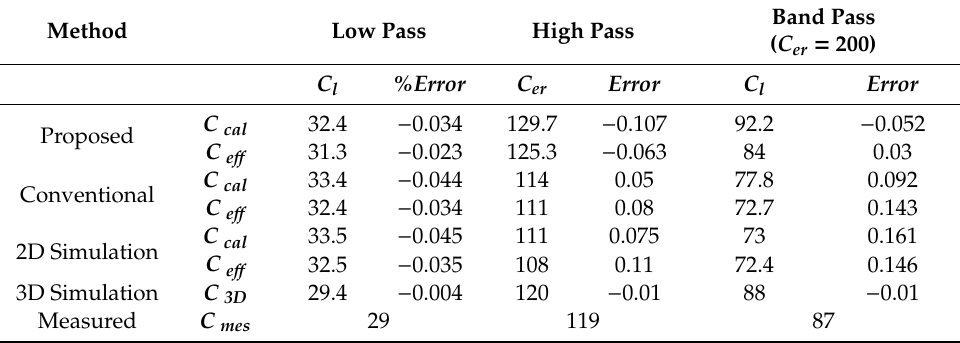
Table 2. Lumped capacitor values in pF for 1.5 T birdcage